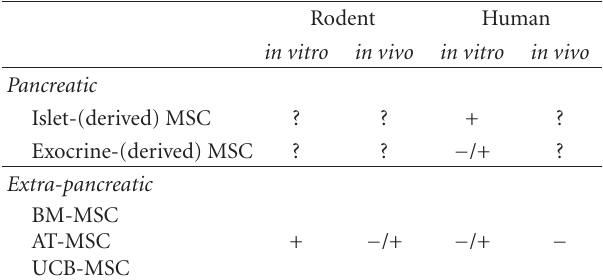
Table 2: Potential sources of de novo β -cells among di ff erentiated adult MSC: BM: bone marrow, AT: adipose tissue; UCB: umbilical cord